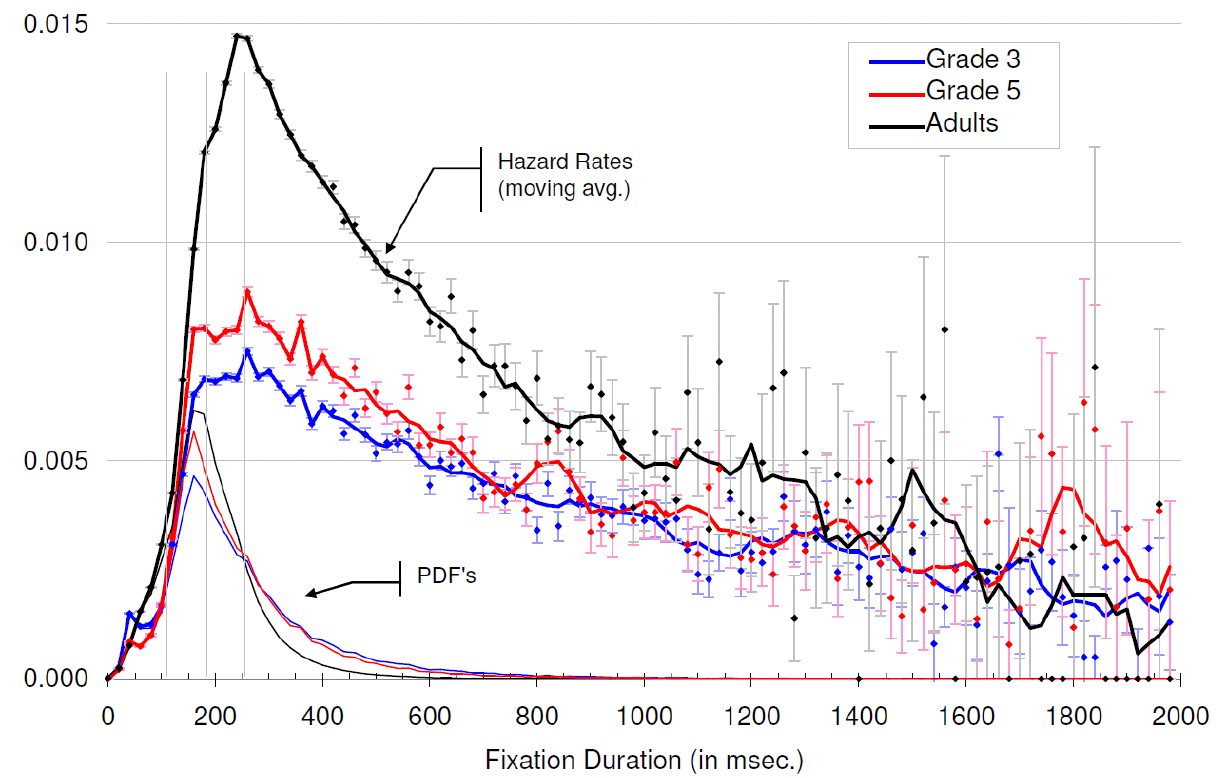
Figure 9. Hazard functions and pdf’s of reading fixation duration based on pooled reading data for 3rd- and 5th-grade children and adults. Moving averaging is used to smooth the hazard function after